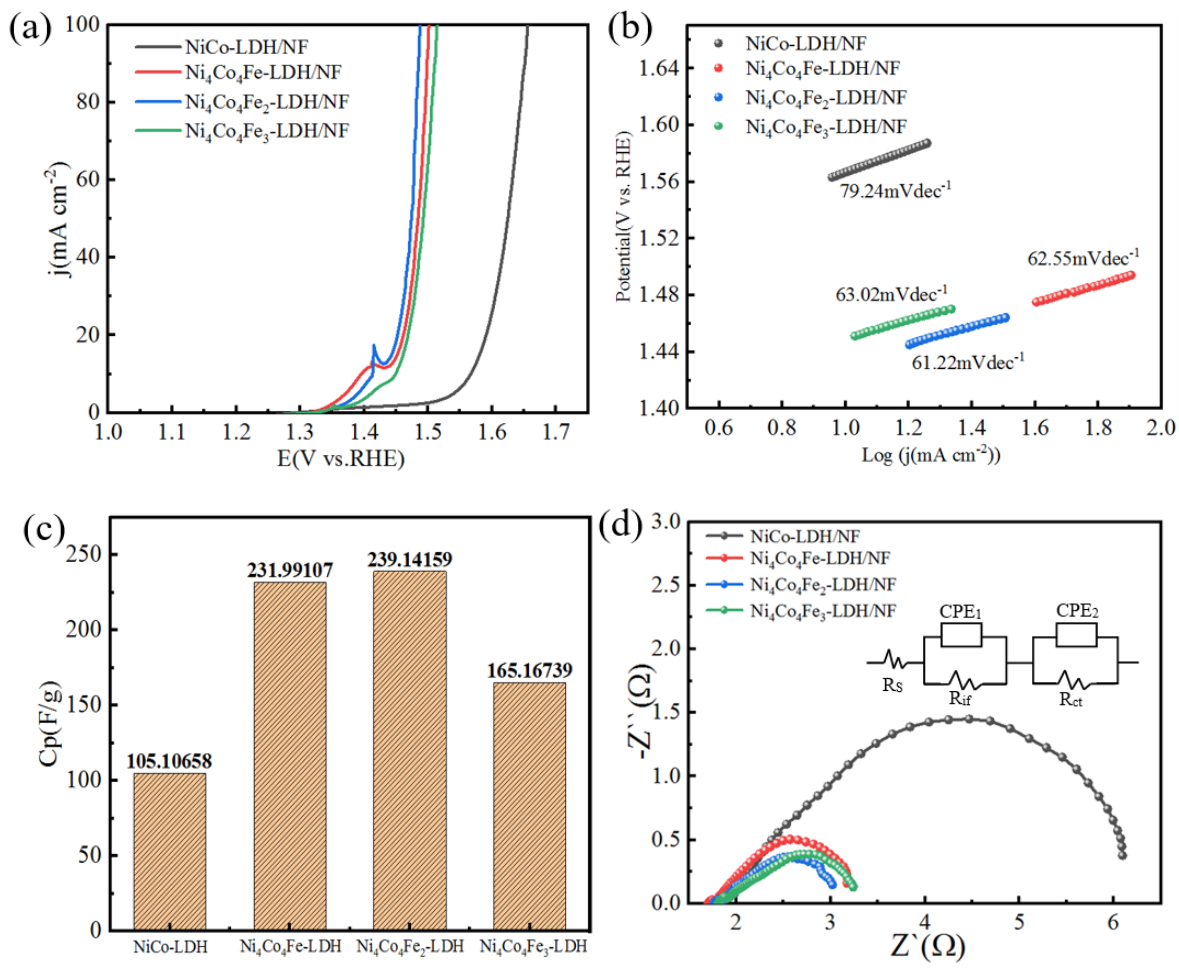
Figure 7. Polarization curves of Ni − Co based LDH electrode catalysts. ( a ) LSV curves of the electrode catalysts in an O 2 − saturated 1.0 M KOH solution at the scan rate of 2 mVs − 1 . ( b ) Tafel plot (overpotential vs. log current) derived from the corresponding polarization curves. ( c ) Specific capacitance values calculated from CV tests (as mentioned in Section 2.4). ( d ) Nyquist plots recorded at the overpotential of 1.48 V vs. RH.